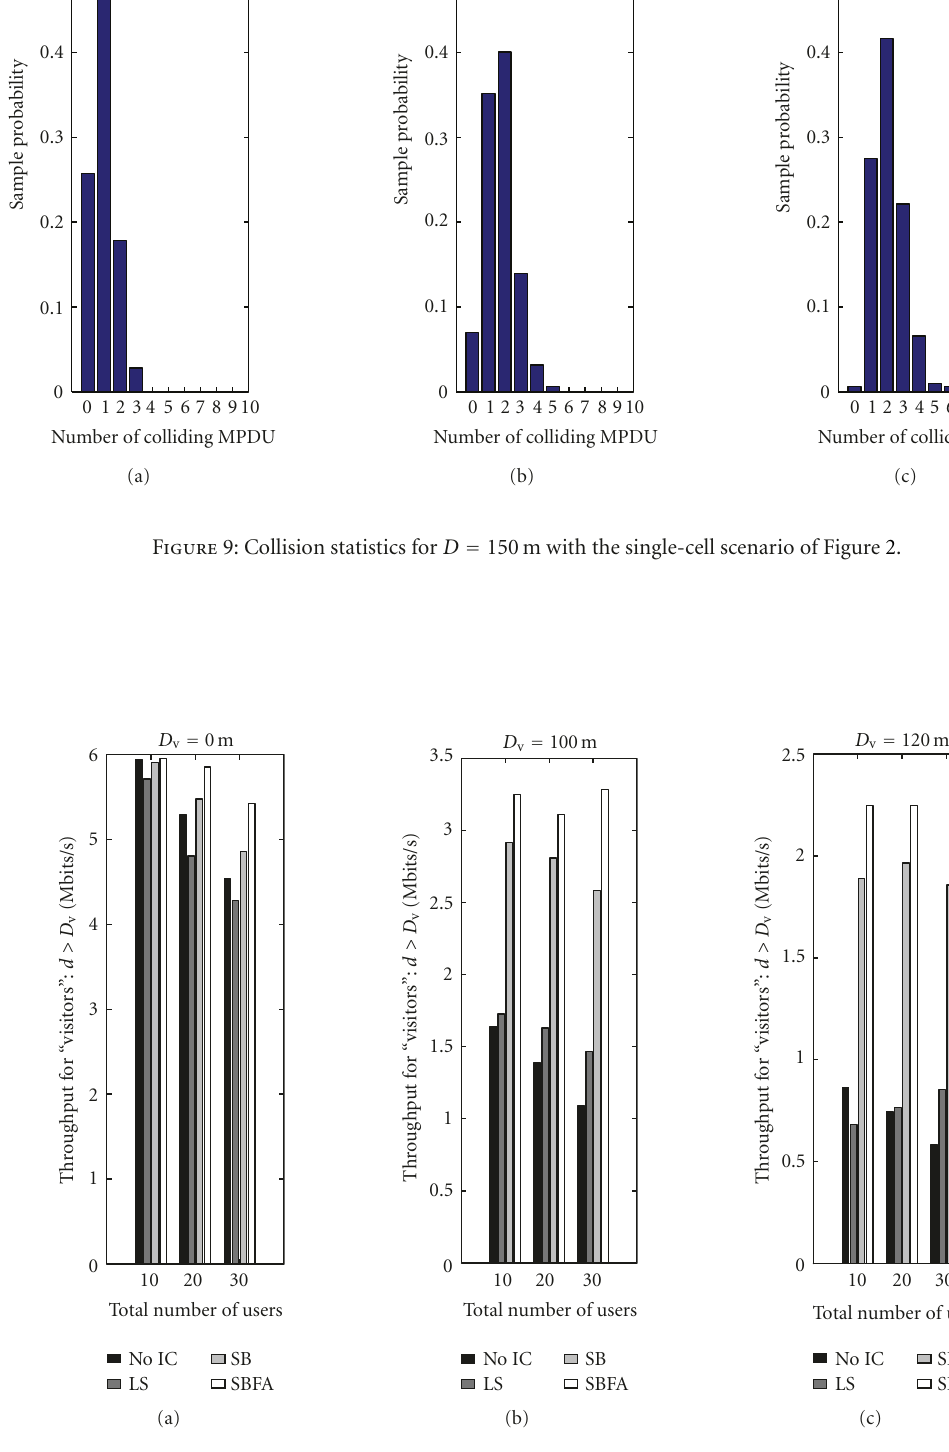
Figure 10: Visiting user throughput for D = 150 and N = 4 for no IC, LS, SB, and SBFA algorithms (left to right for each total number of users) with the single-cell scenario of Figure